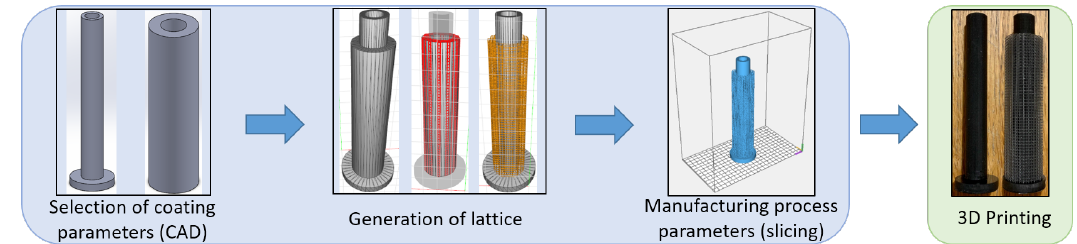
Figure 2. Process of design and manufacturing a porous